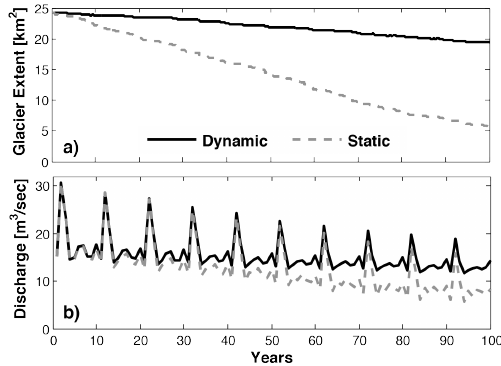
Fig. 13. Hypothetical long-term simulation demonstrating the dif- ferences of simulated (a) glacier extent within the drainage area (422km 2 ) and (b) August discharge using the dynamic (black, solid) and static (gray, dashed) model configurations. The models were forced with meteorological data from 1998–2007 that was re- peated and perturbed with a linear warming trend (0.03 ◦ Cyr − 1 ) , creating a 100 years time